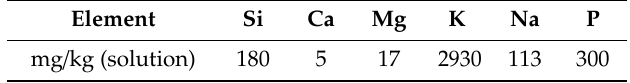
Table 1. Chemical composition of rice bran ash mineral extract